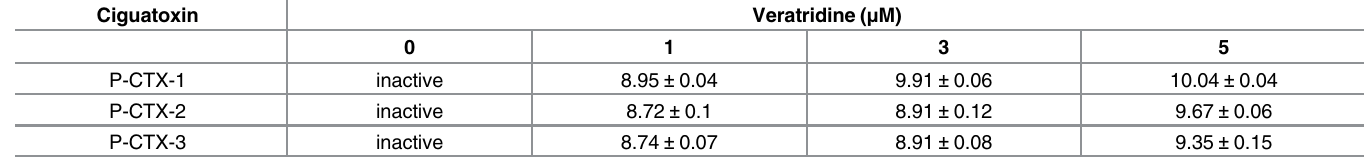
Table 2. Potency (pEC 50 ± SEM) of P-CTX-1, -2 and -3 to potentiate veratridine responses in SH-SY5Y cell FLIPR assay (n = 3).